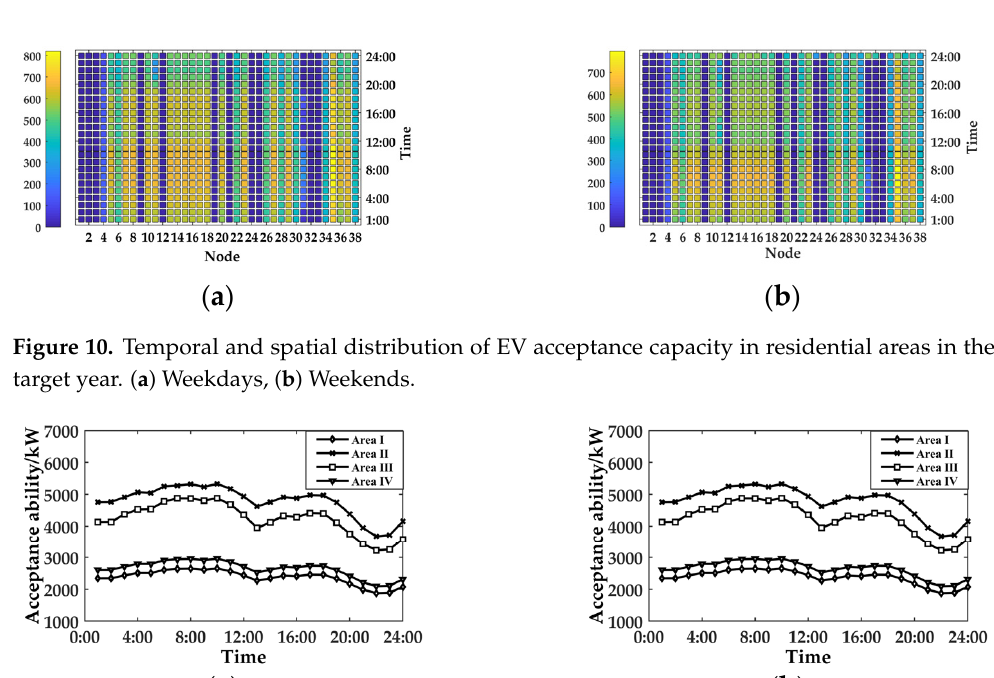
Figure 11. The maximum charging load that can be connected to each partition of the distribution